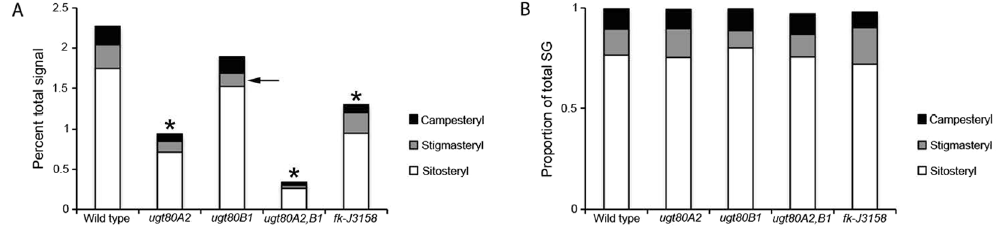
Figure 1. Steryl glucoside (SG) content in roots of wild-type and mutant lines. ( A ) Total steryl glucosides (SG), and sitosteryl, stigmasteryl, and campesteryl glucosides were quantified as percent total signal by ESI-MS/ MS for wild type, ugt80A2 , ugt80B1 , ugt80A2,B1 and fk-J3158 . Significant reductions of SGs in comparison to wild-type levels were found in ugt80A2 , ugt80A2,B1 and fk-J3158 ( p < 0.001, T-test; indicated by asterisks). The ugt80B1 mutant showed a significant reduction in stigmasteryl glucosides only ( p < 0.001, T-test; indicated by arrow). ( B ) Campesteryl, stigmasteryl and sitosteryl glucosides as a proportion of total SG in wild-type and mutant lines. Stigmasteryl glucosides make up disproportionately less of the total signal in ugt80B1 mutants when compared to wild type ( p < 0.01, Dunnett’s Test). Note that the sum of these proportions is slightly less than 1 due to the presence of trace amounts of brassicasteryl and cholesteryl glucosides.